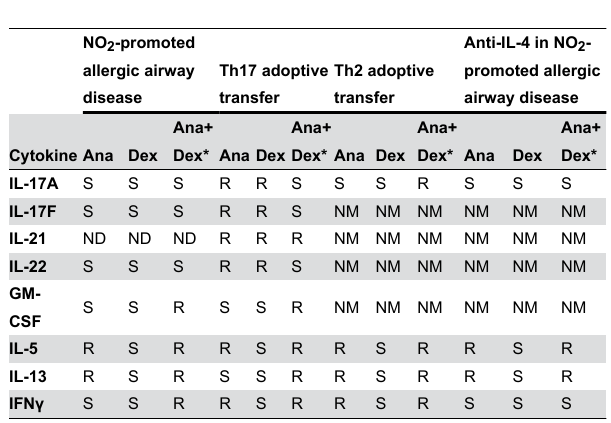
Table 1. Summary of anakinra and dexamethasone sensitivity